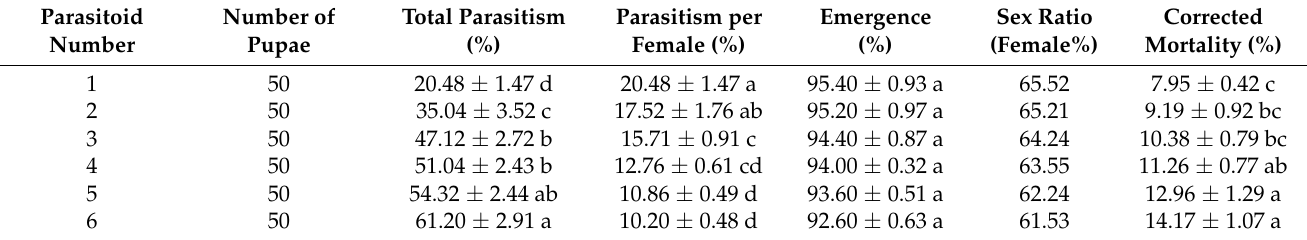
Table 2. Effects of Spalangia endius parasitoid density in relation to the host pupae of Bactrocera cucurbitae